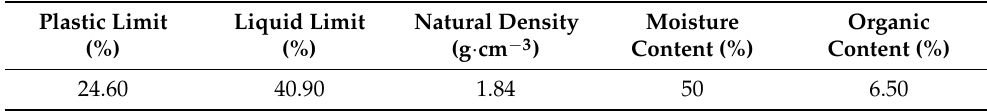
Table 1. Main physical and mechanical indices of subgrade soil.